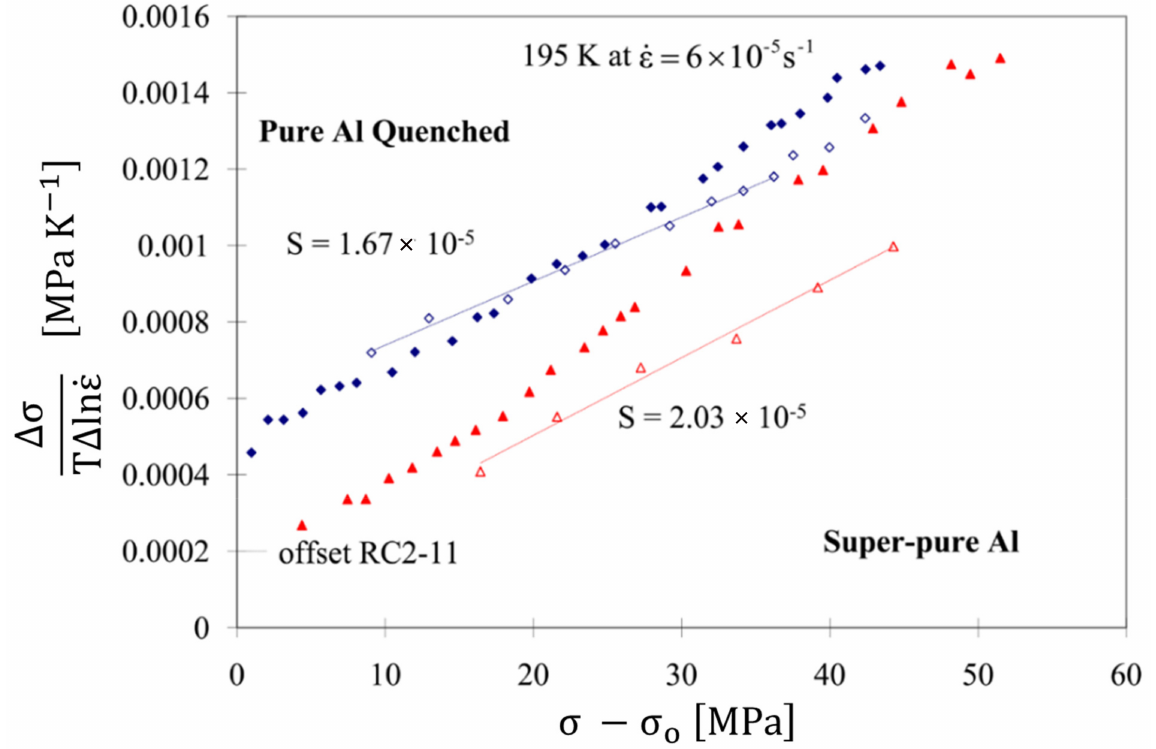
Figure 6. Haasen plot comparing down-change (filled symbols using 1/10 change) with up-change (open symbols) [35]. The slope for the quenched and aged to form nano-void specimen, RC2-11, is lower than that for the super-pure one. Note the origin offset for RC2-11.